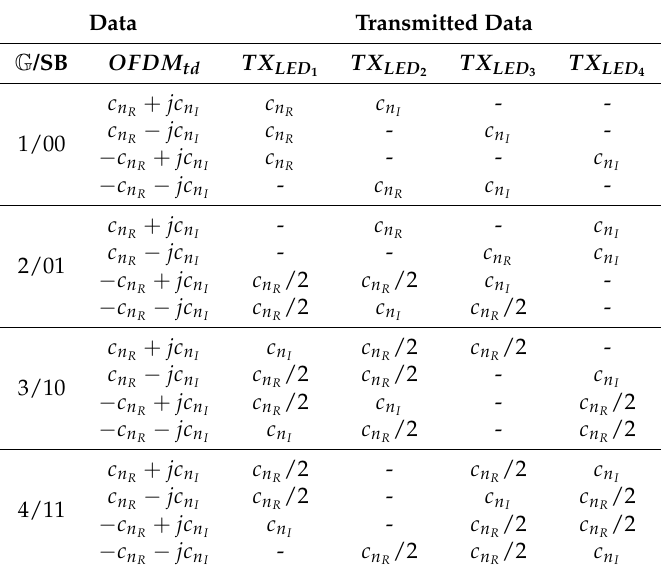
Table 1. Example for the ESI-LED transmission mechanism for n t = 4.